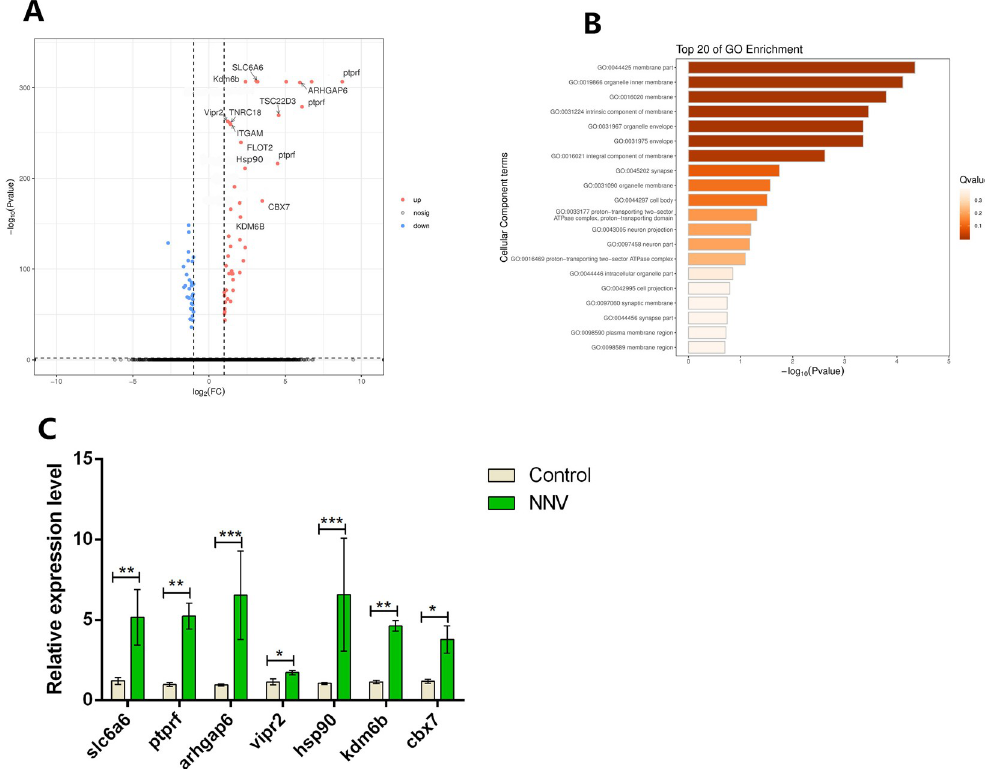
Fig 8. Comparison of gene expression of GLU1 and GLU3 cells between control and RGNNV-infected fish. (A) The volcano plot shows the selected DEGs of immune cells from control vs. RGNNV-infected fish. Only genes specifically upregulated in GLU1 and GLU3 cells were evaluated. Each red dot denotes an individual gene with adjusted P < 0.05 (P- value adjusted by false discovery rate in MAST), others are non-significant genes. (B) GO terms are labeled with name and ID and sorted by − log10 (P) value. The top 20 enriched GO terms are shown. (C) The genes for which expression levels increased after RGNNV infection in GLU1 and GLU3 cells. Data are expressed as means ± SD. � p < 0.05, �� < 0.01, or ��� <